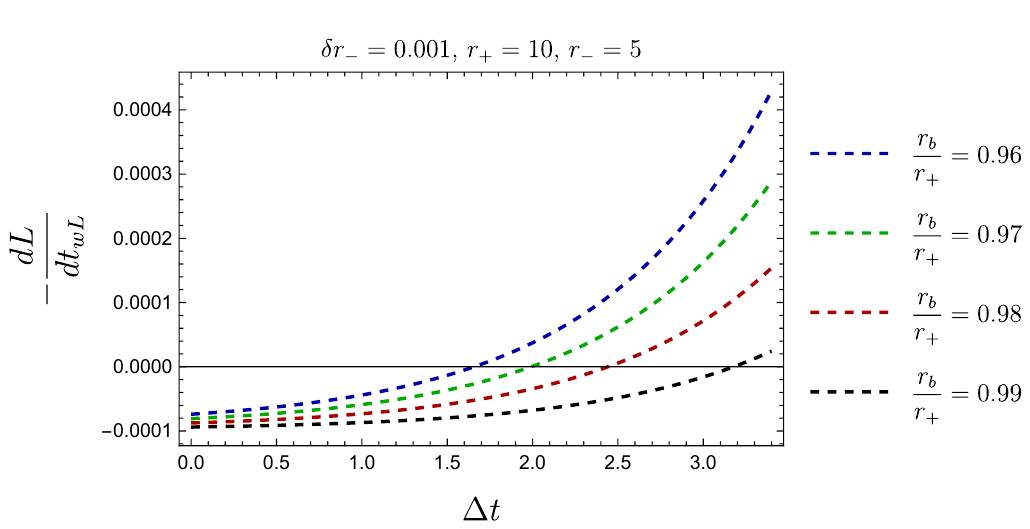
Figure 12 . Plot of the derivative of the length associated to the interior OTOC for different particles. Notice how the zero shifts towards larger ∆ t as the particle bounces closer to the